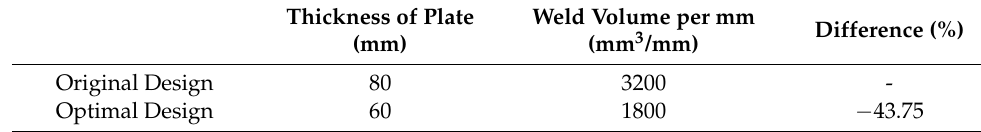
Table 7. Comparison of welding